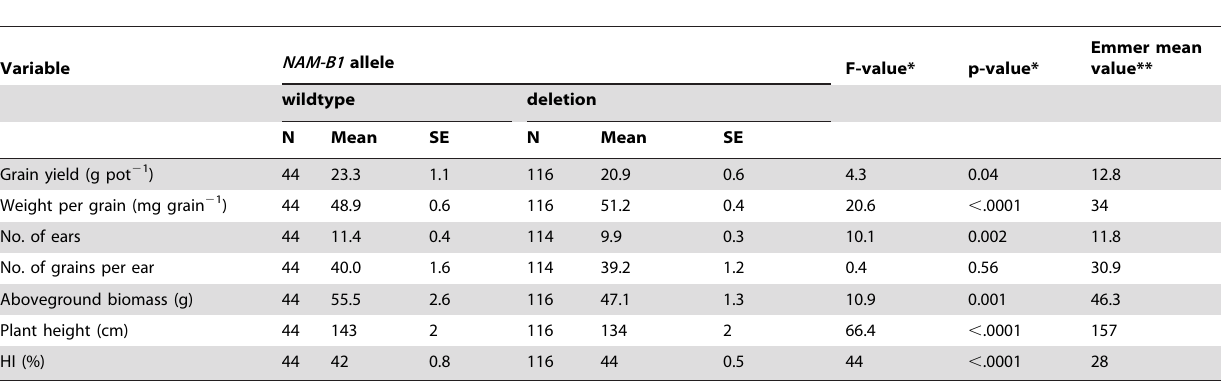
Table 2. Means of some agronomic traits for the varieties grouped based on NAM-B1 allele.